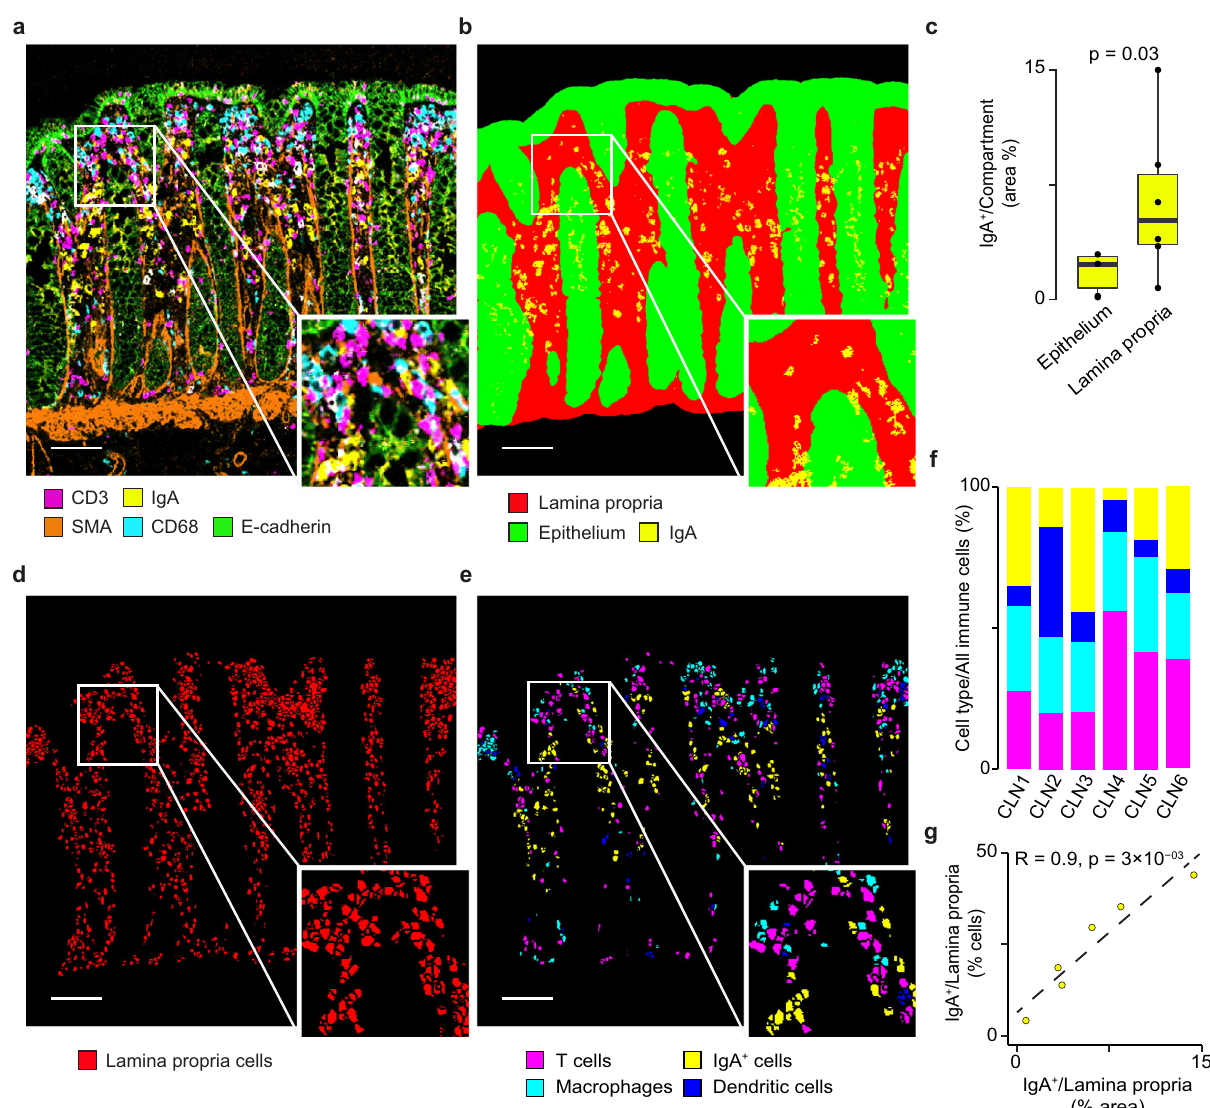
Fig. 2 IgA quanti fi cation in human colon mucosa. a IMC image of a representative sample (CLN6) of normal colon mucosa after extraction and normalisation of raw data. b Masks de fi ning the lamina propria and the epithelial compartments overlaid with IgA + areas. Lamina propria and epithelial masks were obtained by thresholding the vimentin and E-cadherin channels, respectively. c Comparison of normalised IgA + areas in the lamina propria and epithelial compartments in six independent biological samples (CLN1-CLN6). Normalised areas were measured as the proportion of IgA + area over the lamina propria and epithelium masks, respectively. Data are presented as a box centred around the median and extending from the fi rst to the third quartile. Whiskers represent the minimum and maximum values. An exact p value was calculated using a two-sided Wilcoxon test. d Outlines of the cells in the lamina propria. After single-cell segmentation, all cells overlapping with the lamina propria mask by at least 30% of their area were considered as cells resident in the lamina propria. e Outlines of immune cells resident in the lamina propria identi fi ed according to the highest overlap between their area and the masks for IgA + cells, T cells, macrophages and dendritic cells. f Relative proportions of T cells, IgA + cells, macrophages and dendritic cells over all immune cells in the lamina propria across CLN1-CLN6. g Correlation between normalised IgA + area and the proportion of IgA + cells over the total immune cells in the lamina propria in six independent biological samples (CLN1-CLN6). Pearson correlation coef fi cient R and associated p value based on Fisher ’ s Z transform are shown. Images in panels ( a ), ( b ), ( d ), ( e ) were derived from a representative sample (CLN6, Supplementary Data 1). CD3 and T cells, magenta; IgA and IgA + cells, yellow; Smooth Muscle Actin (SMA), orange; CD68 and macrophages, cyan; E-cadherin and epithelial cells, green; Lamina propria and lamina propria cells, red; Dendritic cells, blue. Scale bar in all images = 100 μ m. Source data are provided as a Source Data fi